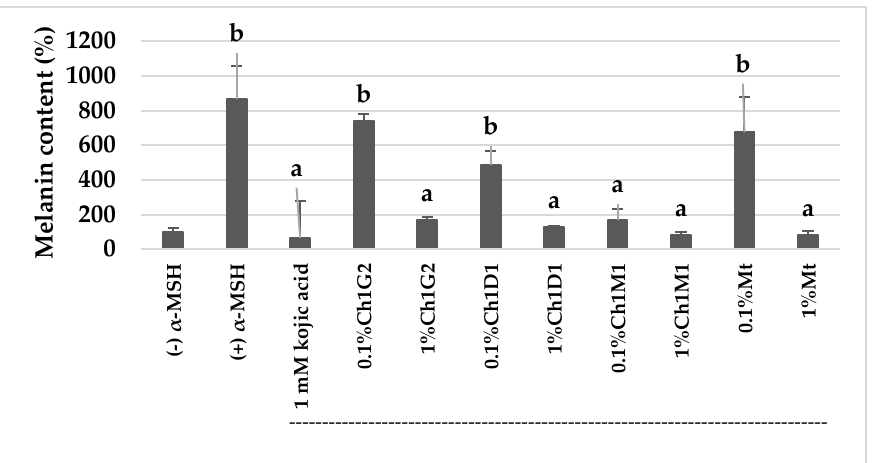
Figure 2. The percentage of extracellular melanin content from B16-F10 melanoma after treatment with kojic acid (positive control), NADES and methanol (MT) extracts of M. alba in the presence (+) or absence (−) of α-MSH (10 nM) (mean ± SD, n = 3), a,b indicated p -value < 0.01 among positive α-MSH groups; significance differences were determined using Duncan’s method.